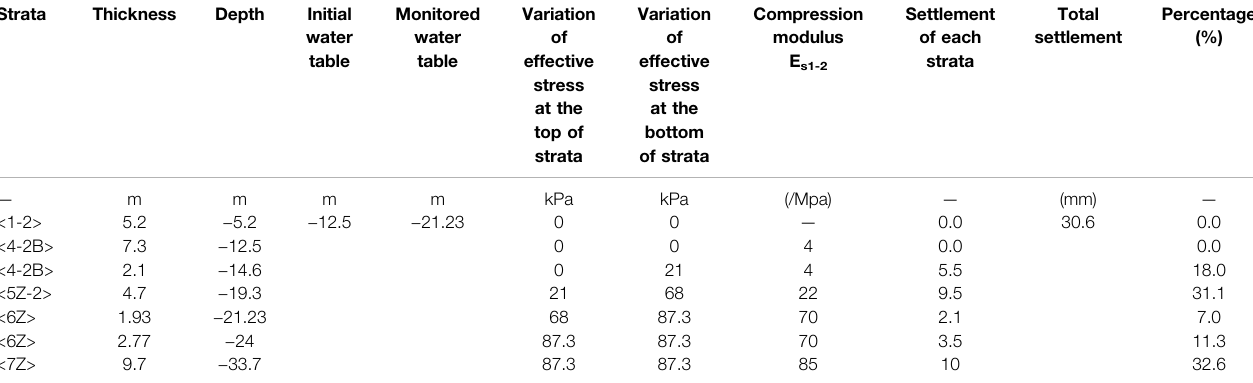
TABLE 3 | Calculation of water loss-induced ground surface settlement. Strata Thickness Depth Initial